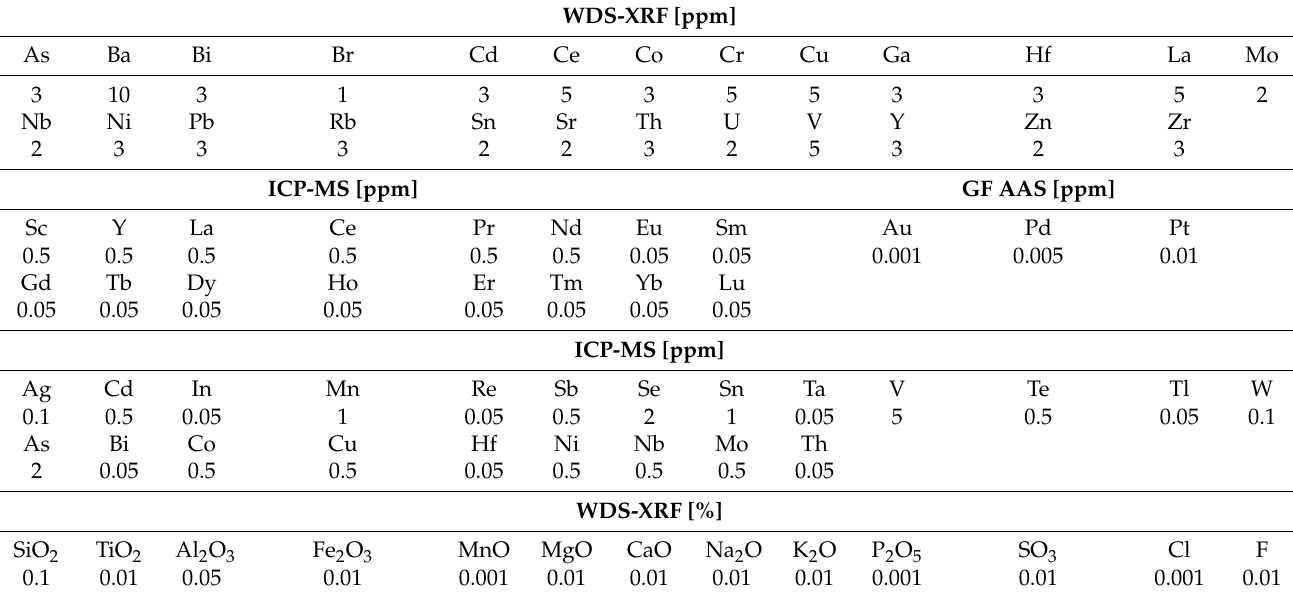
Table 1. The minimum detection limits of element measurements via the applied